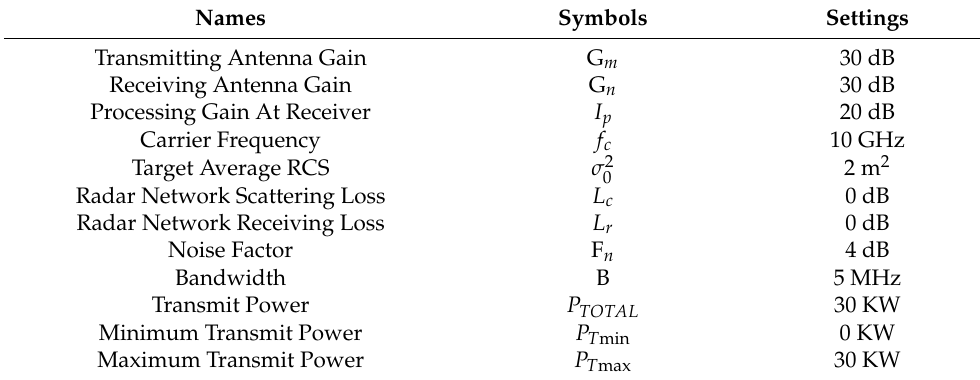
Figure 4. Priority level. Table 2. System parameters. Table 2. System